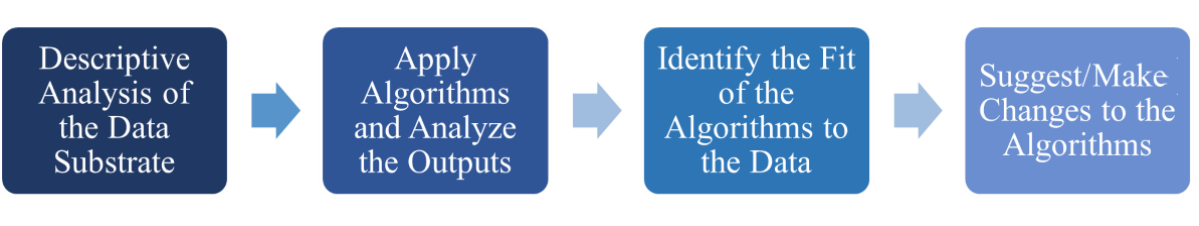
Figure 1. The overall processes of the study, for executing MED.Safe at a second